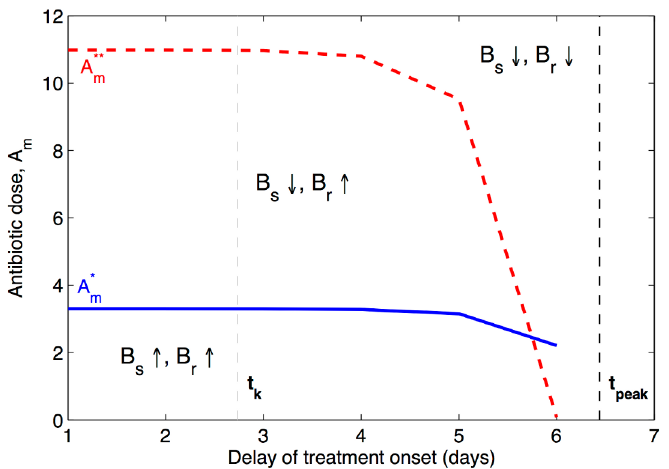
disrupted by treatment, and clearance can be achieved only by prolonged antibiotic pressure. Parameters as in Table 1. The time it takes the pathogen load to trigger immune activation (i.e. reach the immunity threshold k ), in the absence of treatment, denoted by t k , is given by the gray vertical line. The time it takes the host immunity to trigger bacterial decline (i.e. time for B ( t ) to reach its peak), in the absence of treatment, denoted by t peak is given by the black vertical line. An optimal delay usually sits in the middle of this